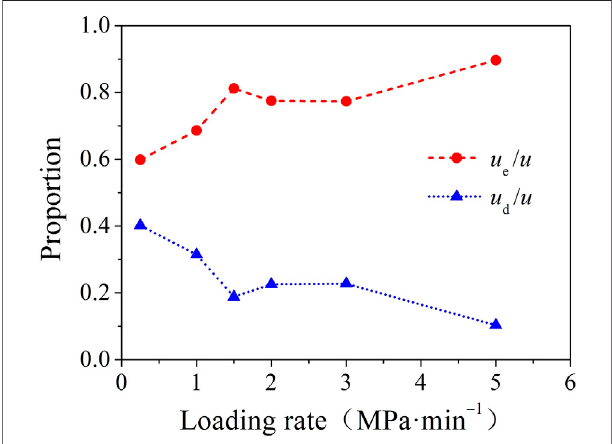
FIGURE 6 | Relationship between energy density ratio and loading